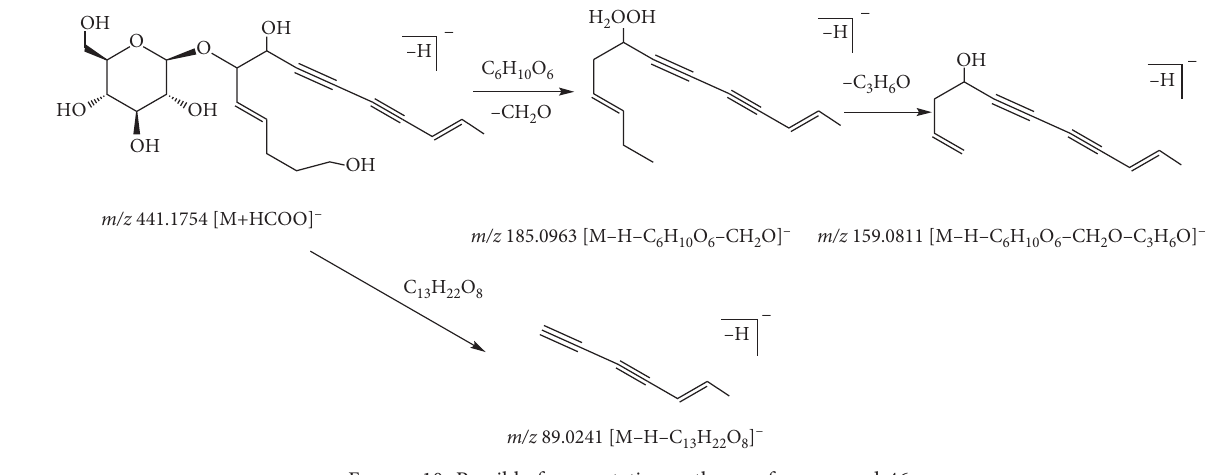
Figure 10: Possible fragmentation pathway of compound